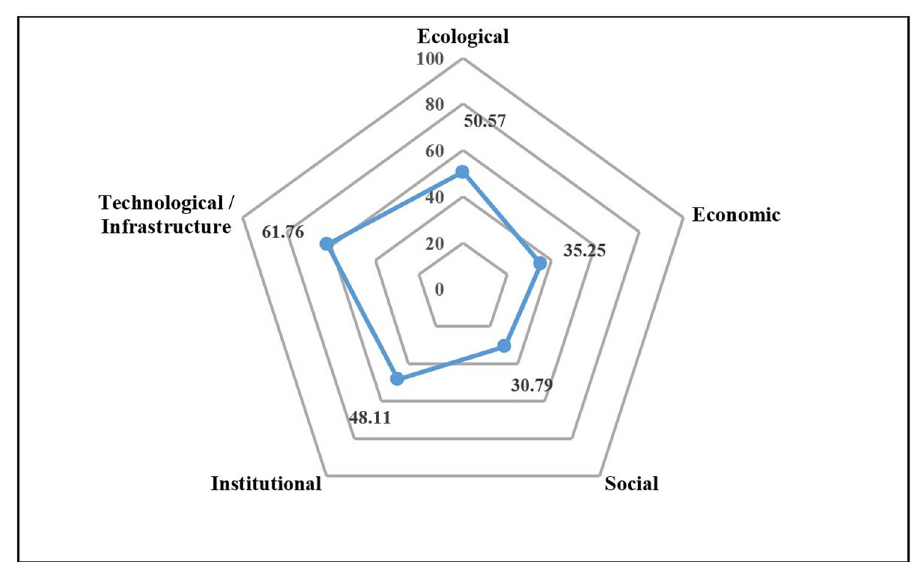
Fig 2. Kite diagram of the sustainability index of increasing rice production in Bandung